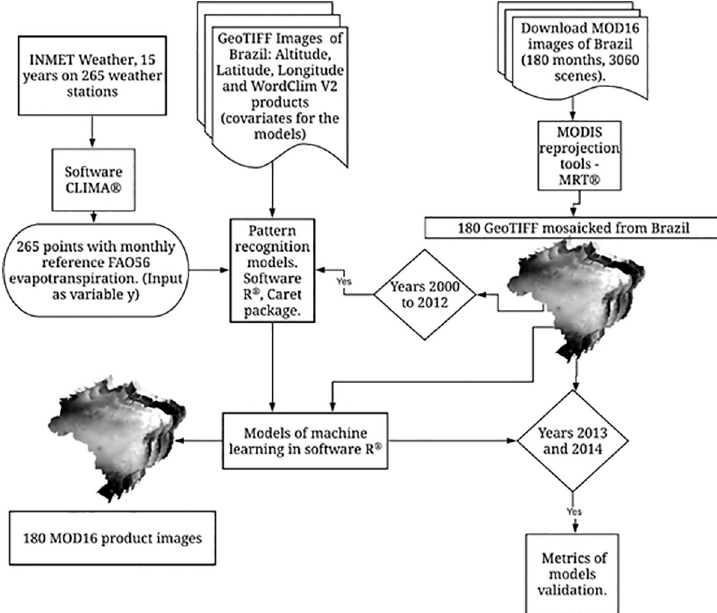
Fig 2. Flowchart of the methodology used to model the ETo. The figure was elaborated with the TIFF files processed in the paper using the free software QGIS [35].